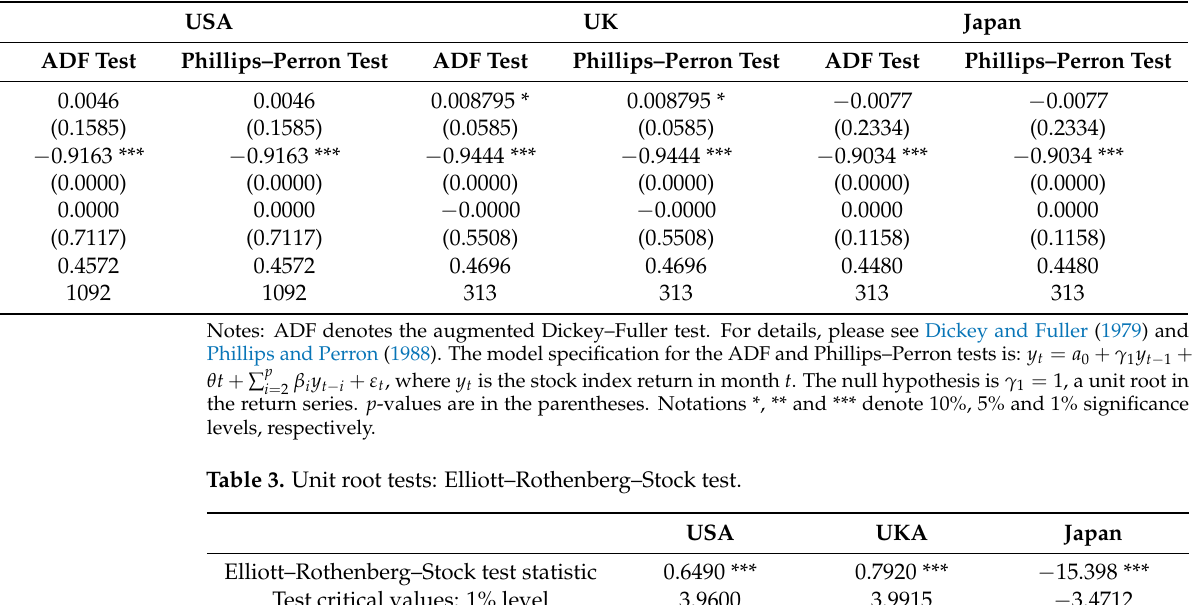
Table 2. Unit root tests: Augmented Dickey–Fuller and Phillip–Perron Tests.